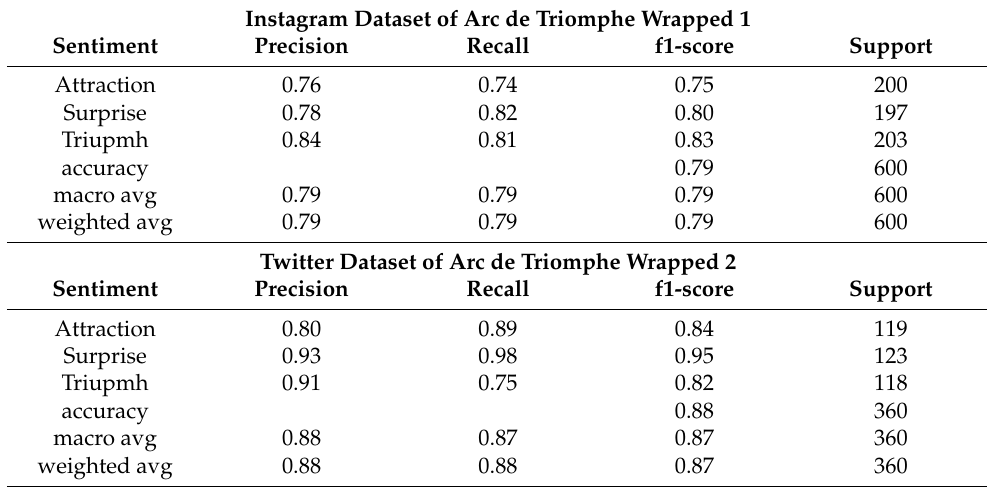
Table 6. Outcome evaluation by the classification report.